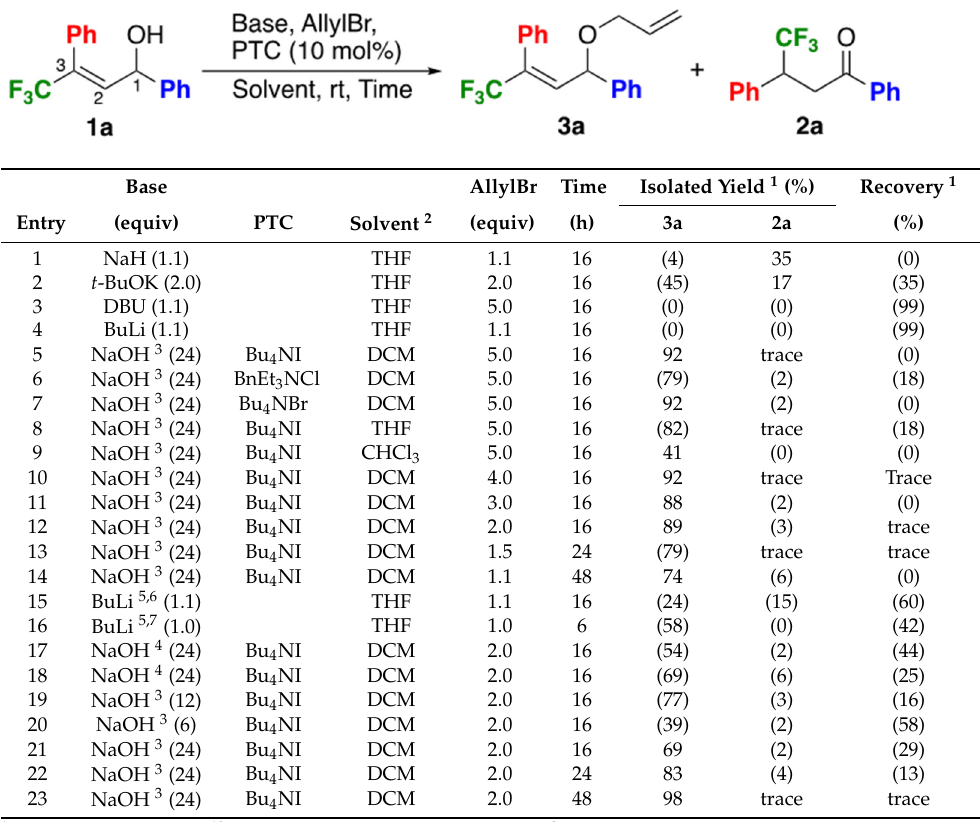
Table 1. Optimization of the reaction conditions for the O -allylation of 1a .